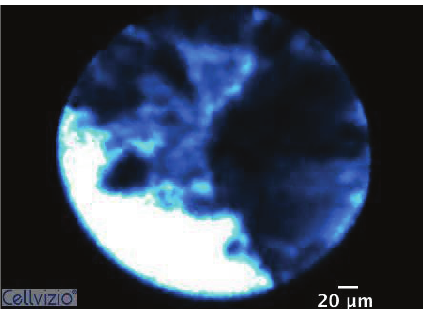
Figure 3: Dark clumps suggesting malignancy (according to Miami Classification) seen during a confocal procedure using a CholangioFlex.